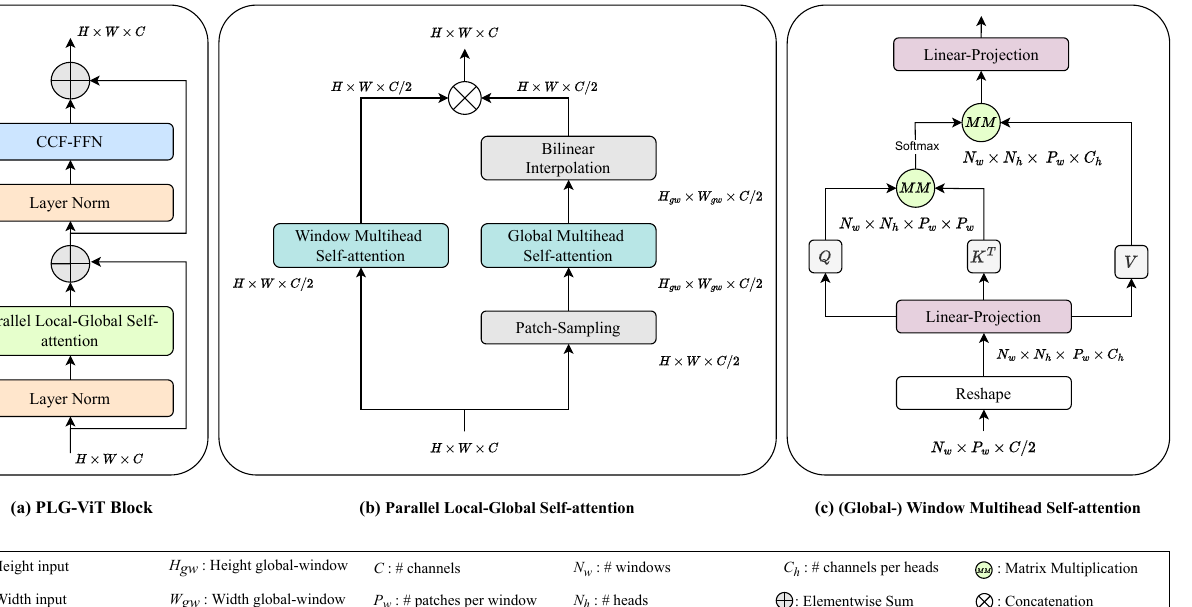
(b) Parallel Local-Global Self-attention (c) (Global-) Window Multihead Self-attention